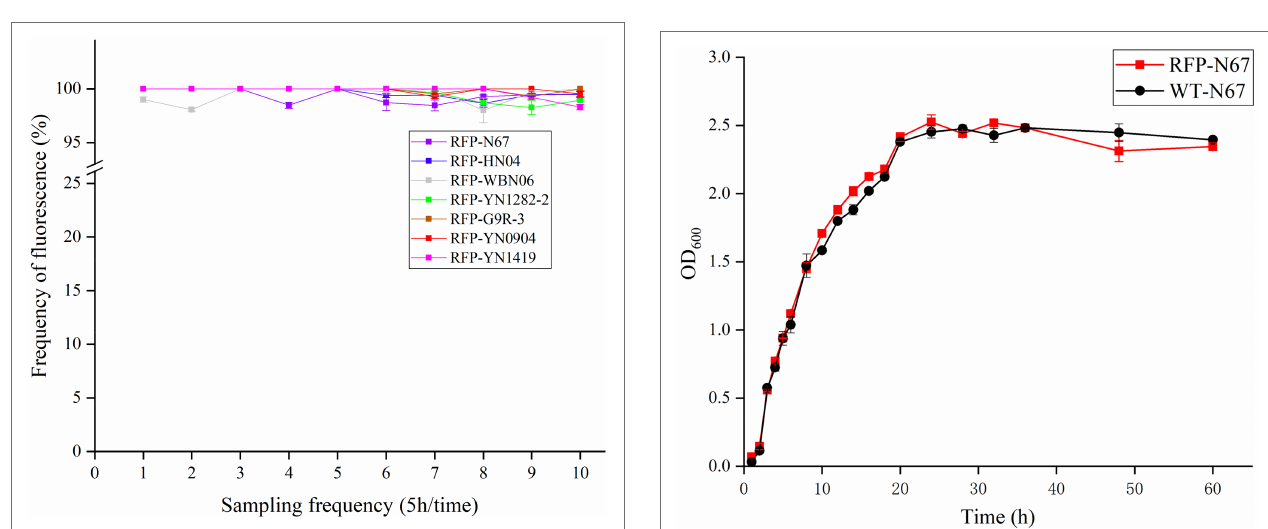
FIGURE 4 | The growth rate of RFP-N67 compared to wild-type N67. OD600 measures were used to determine bacterial growth rate. Three replicates were